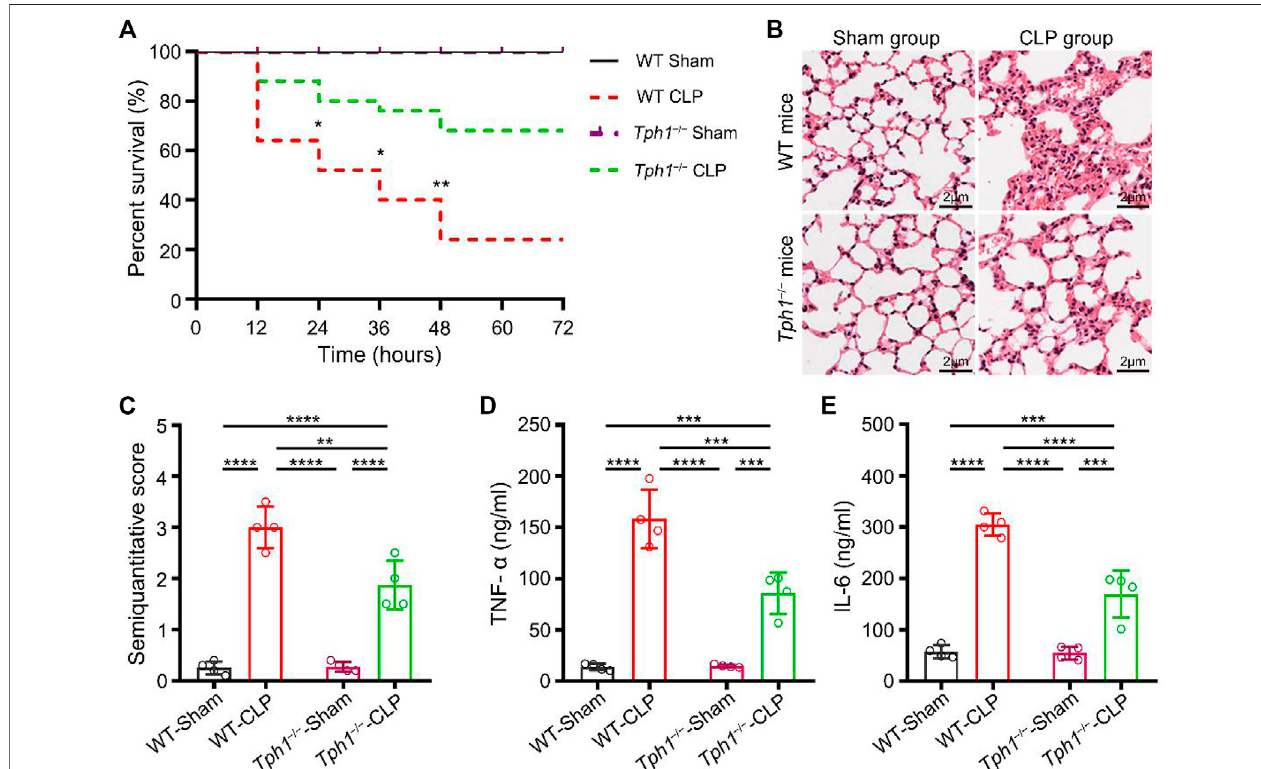
FIGURE 1 | Peripheral 5-hydroxytryptophan (5-HT) de fi ciency improves the survival rate of septic mice and alleviates sepsis-induced acute lung injury. (A) The survival rate of mice. No deaths occurred in the wild-type (WT) and Tph1 knockout ( Tph1 − / − ) sham groups. Most of the mice challenged with CLP died between 12 and 24 h postoperatively. The survival rate of WT mice was substantially low (only 52.00% at 24 h). In contrast, the survival rate of Tph1 − / − mice was signi fi cantly increased (80.00% at 24 h). Moreover, at 72 h postoperatively, peripheral 5-HT de fi ciency dramatically increased the survival of septic mice from 24.00% to 68.00% ( p < 0.01). For WT and Tph1 − / − sham groups: n (cid:2) 6; for WT and Tph1 − / − cecal ligation and puncture (CLP) groups: n (cid:2) 25. (B) Histopathological changes. Lung specimens from the sham mice showed normal architectures and lesser granulocyte in fi ltration, while lung specimens from WT CLP mice showed severe alveolar structure destruction, hyperemia, thickening of alveolar walls, and extensive granulocyte in fi ltration. On the contrary, lung specimens from the Tph1 − / − CLP mice group showed less severe alveolar structure destruction and mild alveolar wall granulocyte in fi ltration. (C) Semiquantitative score of lung histological injury. Semiquantitative scores in WT CLP mice were signi fi cantly increased compared to sham groups. In contrast, Tph1 − / − CLP mice showed lower semiquantitative scores. (D) Tumor necrosis factor alpha (TNF- α ) concentrations. TNF- α concentrations in bronchoalveolar lavage fl uid (BALF) of WT CLP mice were signi fi cantly increased compared to sham groups. In contrast, Tph1 − / − CLP mice showed lower TNF- α concentrations. (E) Interleukin 6 (IL-6) concentrations. IL-6 concentrations in BALF of WT CLP mice were signi fi cantly increased compared to sham groups. In contrast, Tph1 − / − CLP mice showed lower IL-6 concentrations. For each group: n (cid:2) 4 (B – E) . *p < 0.05, **p < 0.01, ***p < 0.001, and ****p <